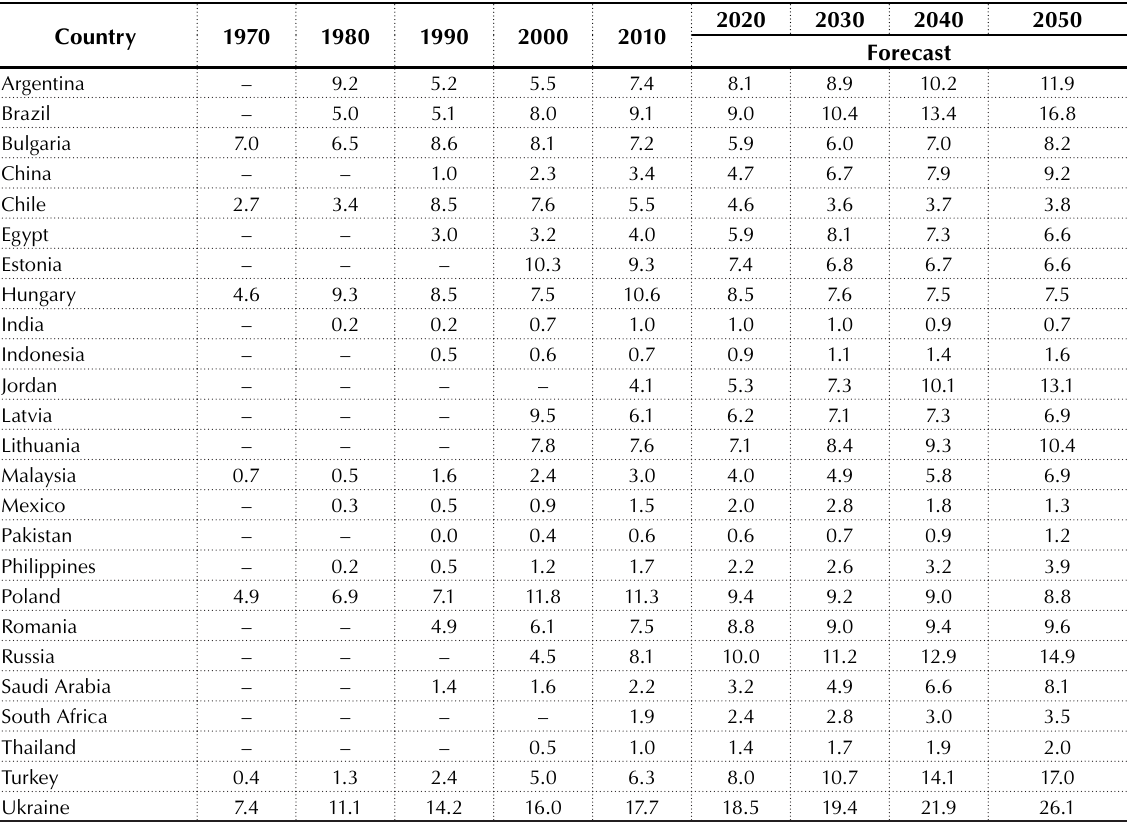
Table 3. The share of government pension provision in GDP of emerging countries,